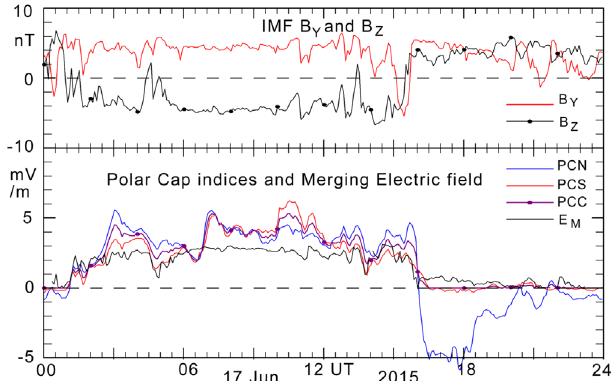
Fig. 1. Upper fi eld: IMF B Y (red line), IMF B Z (black, dots). Lower fi eld: PCN (blue line), PCS (red), PCC (magenta, dots), and E values (black) during 17